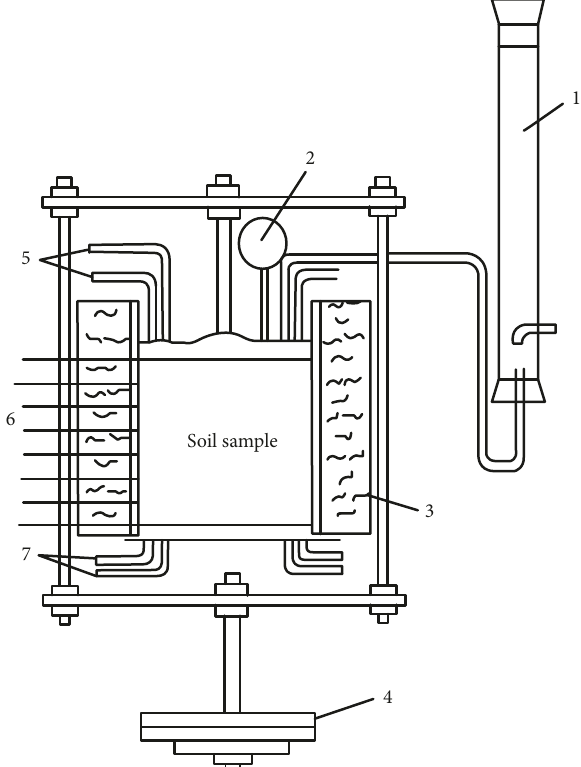
Figure 3: Traditional frost heave experiment apparatus. (1) Water replenishing apparatus. (2) Dial indicator of heave. (3) Thermal insulation material. (4) Pressure apparatus. (5) Positive tempera- ture circulative liquid import and export. (6) Thermistor tem- perature measuring point. (7) Negative temperature circulative liquid import and